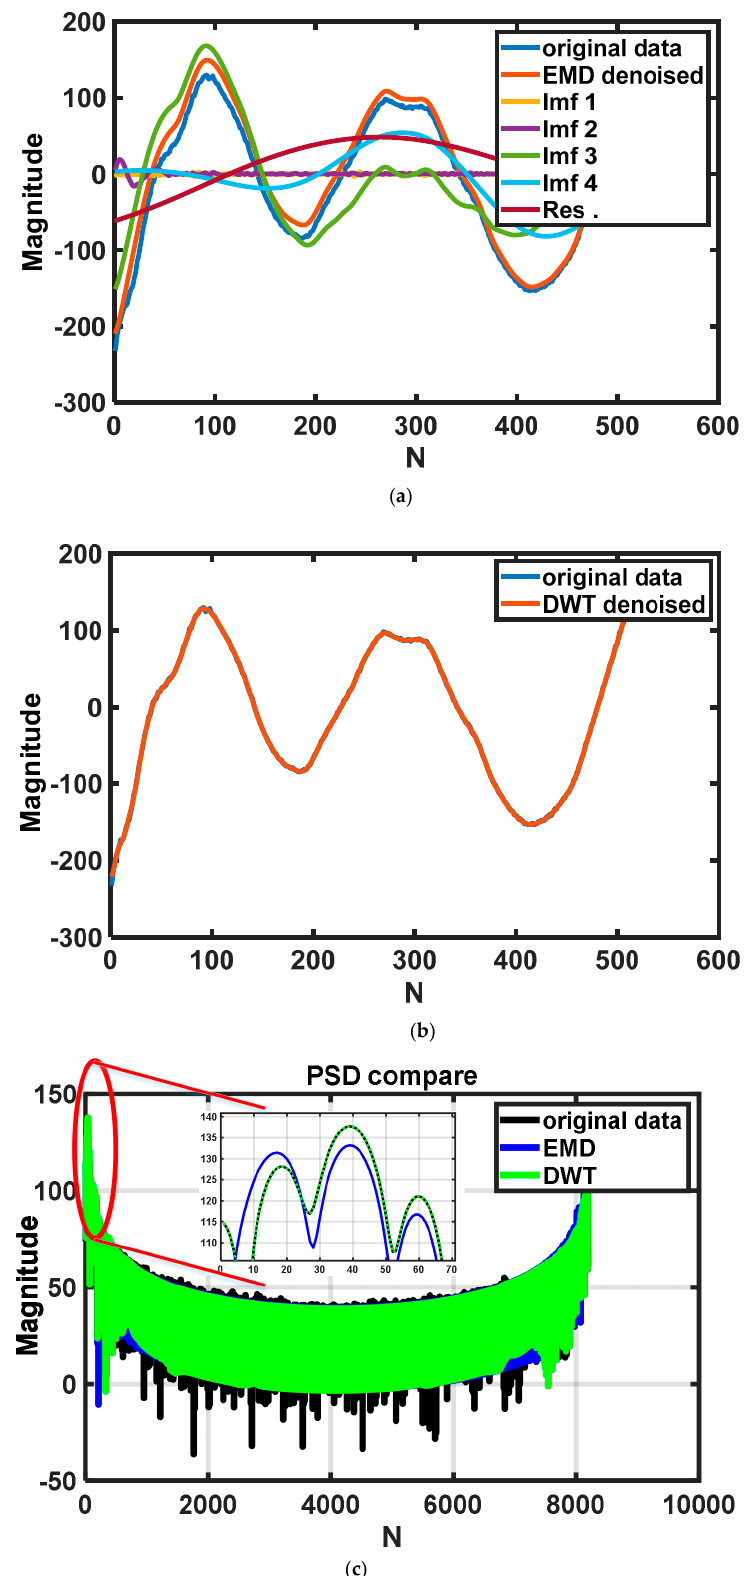
Figure 2. Using different methods to reduce thermal noise: ( a ) components of different frequencies extracted by EMD algorithm; ( b ) time–domain signal after denoised by DWT; ( c ) comparison of the result of EMD and result of DWT and raw data in the frequency domain.